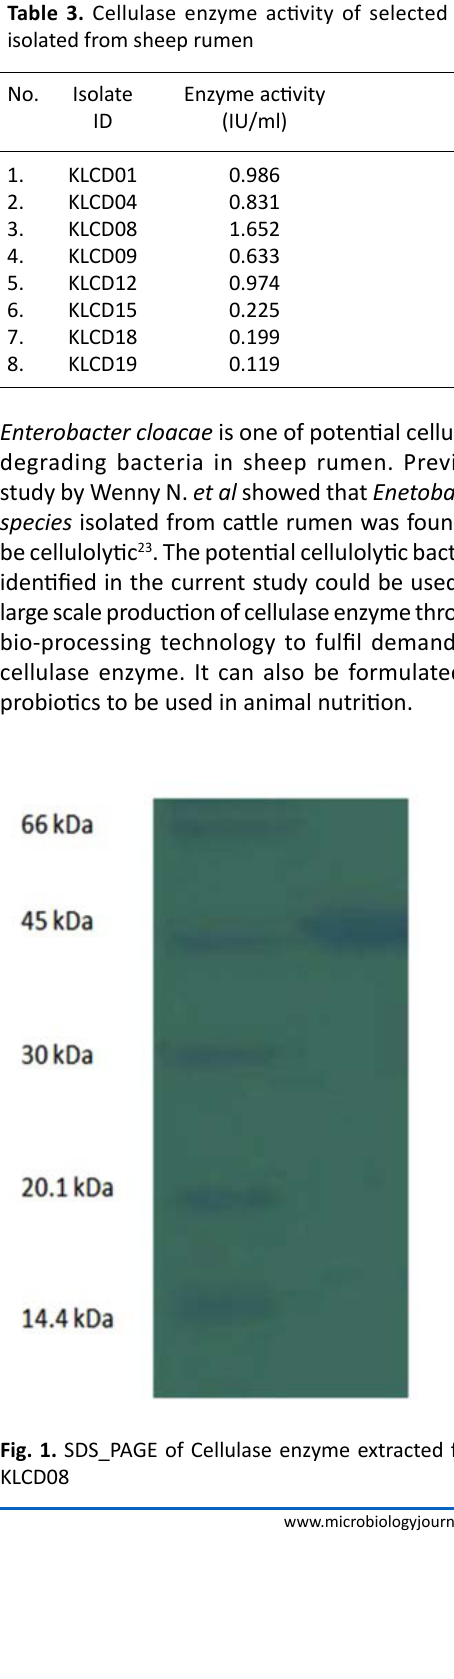
table 3. Cellulase enzyme activity of selected CDB